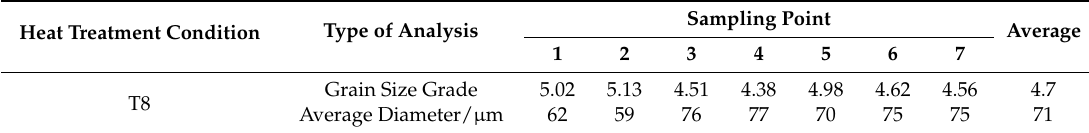
Table 3. Grain size analysis of tensile specimen.